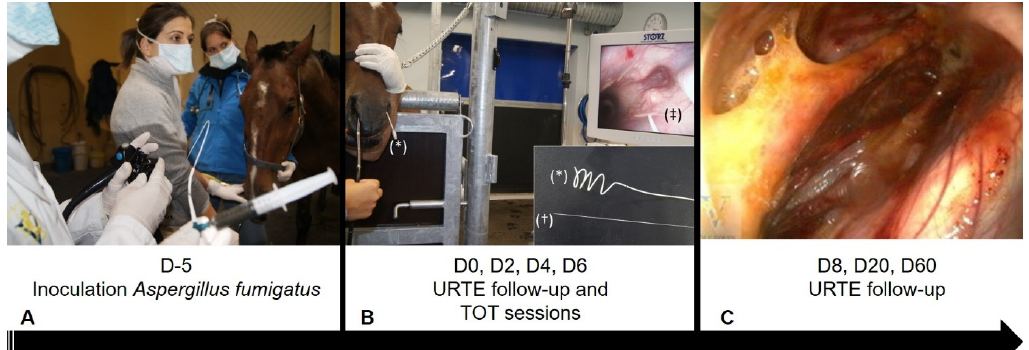
Figure 1. Experimental design and timing of the phase 1 pilot study: ( A ) five days before the first TOT (topical oxygen therapy) session, all GPs (guttural pouch) were inoculated with Aspergillus fumigatus ; ( B ) after URTE (upper respiratory tract endoscopy) assessment, a specific catheter was placed under endoscopic guidance into the GP for oxygen administration. The catheter mounted on a metallic guidewire (†) was advanced on the ventral nasal meatus into the GP (‡). Luer lock and spiraled multiple fenestrated ends of the catheter are visualized (*); ( C ) follow-up URTEs were performed until day 60.